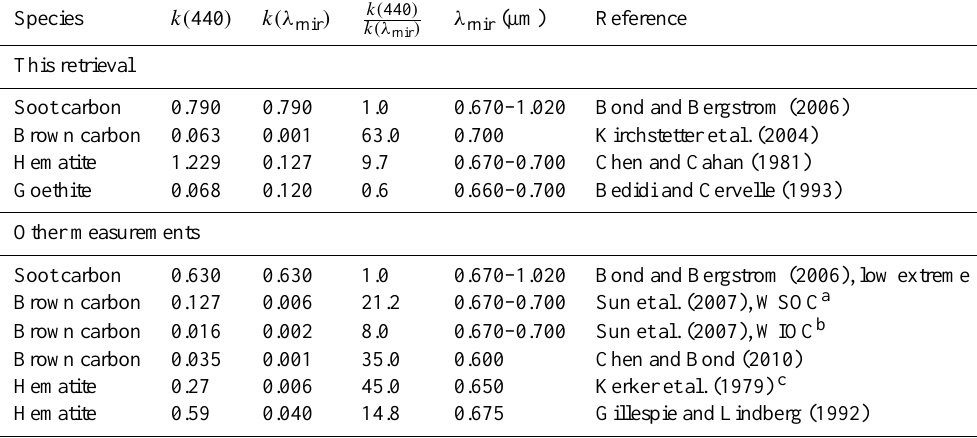
Table 1. Refractive indices used to test sensitivity of this retrieval to component aerosol optical properties. The subscript “rnir” refers to the red and near infrared wavelengths, and k rnir is the average k for the 670–1020nm wavelengths. λ rnir (µm) Reference Species k( 440 ) k(λ rnir ) k( 440 ) k(λ rnir ) This retrieval Soot carbon 0.790 0.790